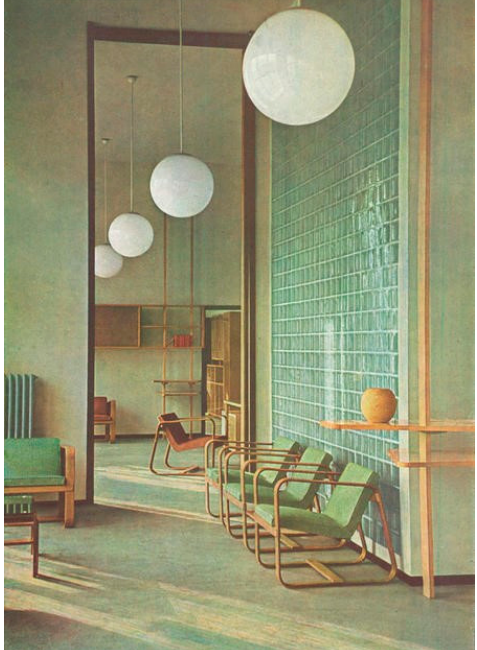
Figure 32. Commercial University Bocconi by Giuseppe Pagano Pogatschnig and Giangiacomo Predeval. Milan (1937–1942). Passage between the Rector’s study and the director’s office. Photo from Domus (1942).